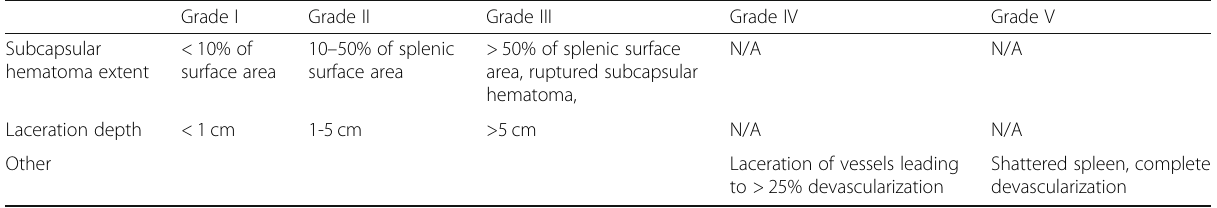
Table 1 AAST splenic laceration grading by CT. Other findings on CT not included in AAST criteria but important for triaging patients include active extravasation and